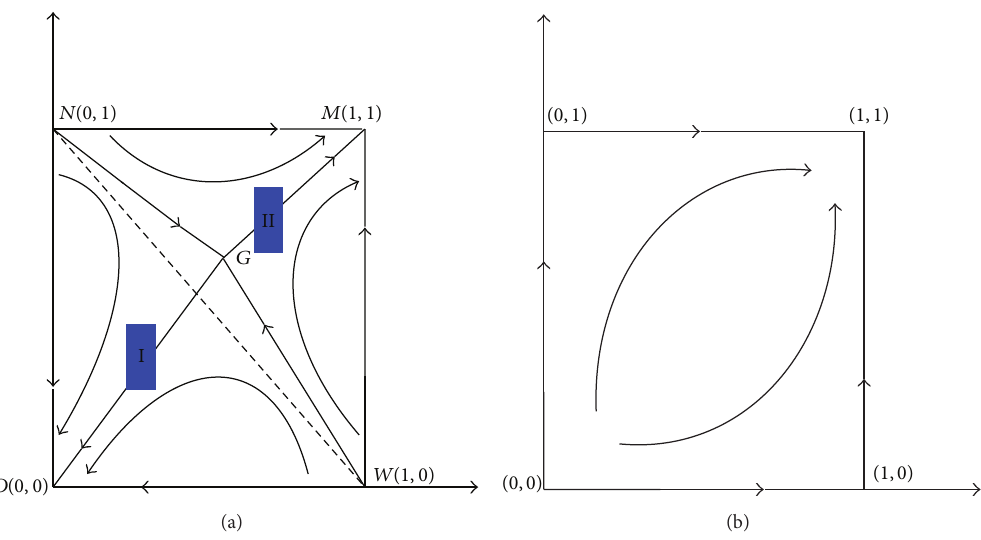
Figure 9: The replication dynamic evolutionary phase diagram of the strategy interaction between